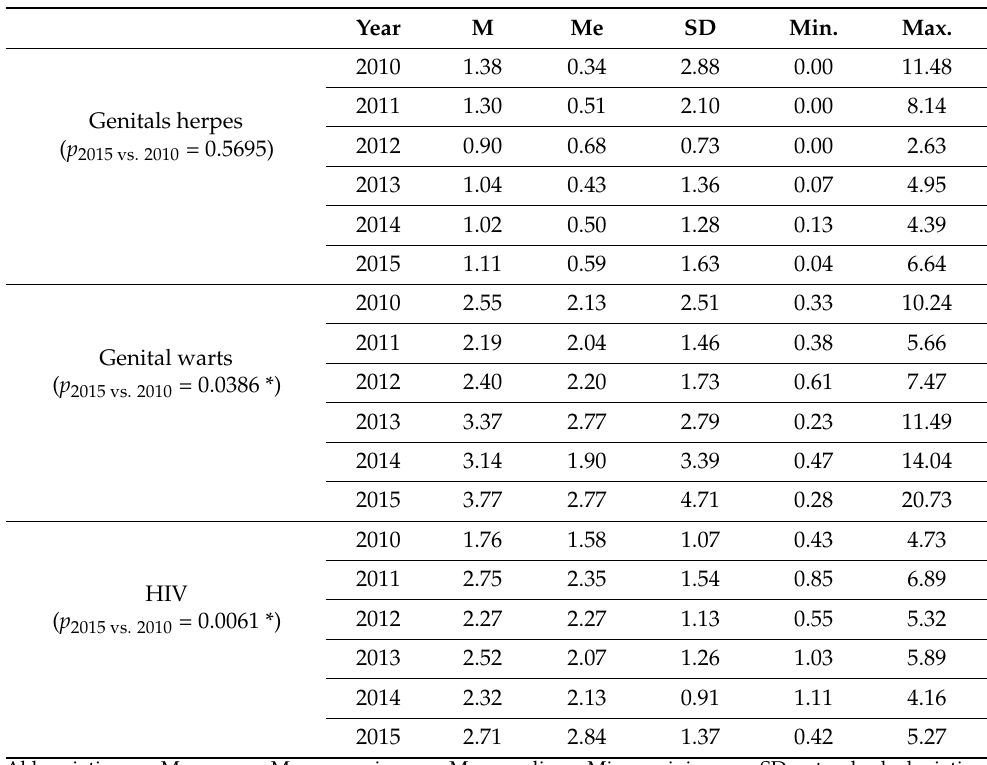
Table 1. Distribution of descriptive statistics of incidence per 100,000 inhabitants for the analysed sexually transmitted infections between 2010 and 2015. Year M Me SD Min. Max.